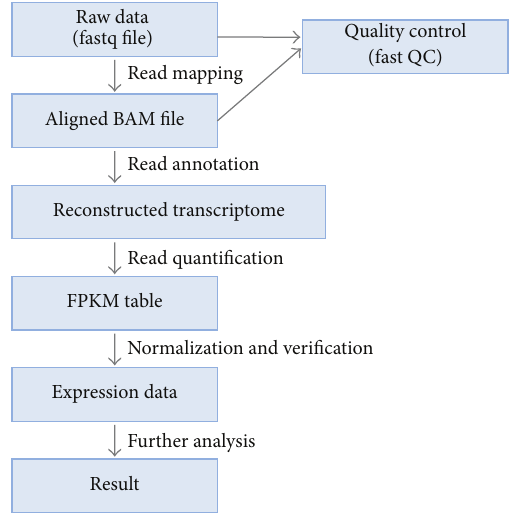
Figure 1: Schematic overview of the transcript analysis of RNA-seq experiment. Briefly, we used TopHat to align raw fastq files and used Cufflinks to read annotation and quantification. FastQC was used to check read